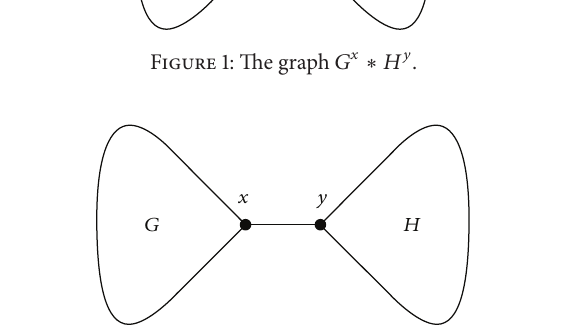
Figure 2: The graph 𝐺 𝑥 + 𝐻 𝑦